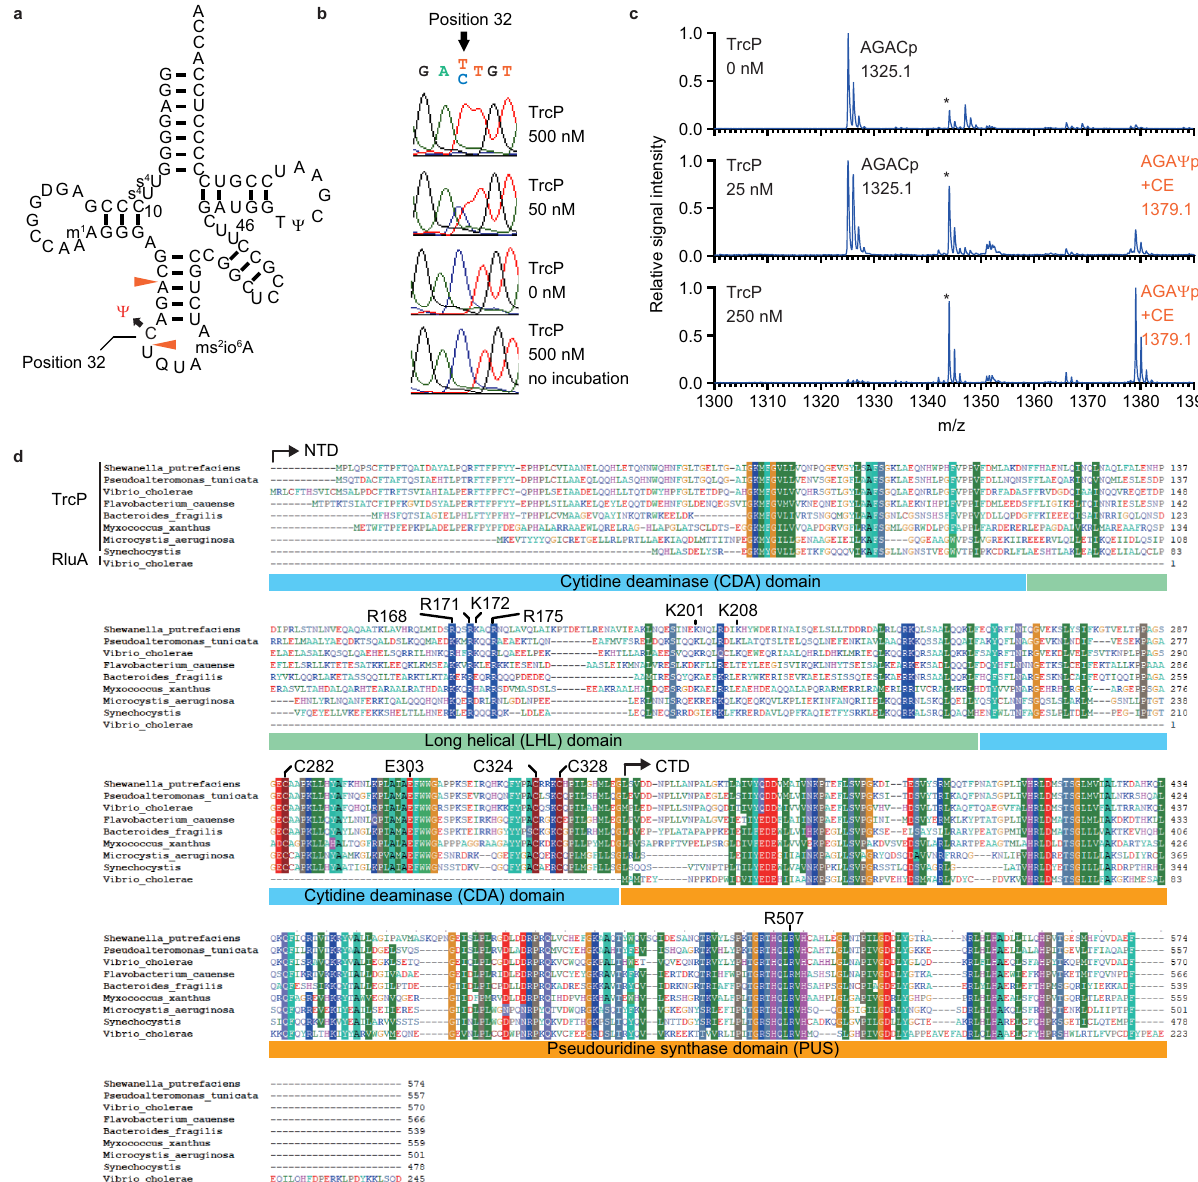
Fig. 1 | TrcP is suf fi cient to catalyze C-to- Ψ editing reaction. a Secondary structure of V. cholerae tRNA-Tyr. The C at position 32 is edited to Ψ . b Sanger sequencing of ampli fi ed cDNA derived from 250 nM tRNAs incubated with recombinant TrcP protein. TrcP concentrations are shown on the right. In the traces,redcorrespondstoT,andbluecorrespondstoC. c MALDI-TOFanalysisof an oligo-protected portion (positions 10 – 46) of tRNA-Tyr after incubation with recombinant TrcP protein. The tRNA fragment was treated with acrylonitrile to introduceacyanoethylgroup(53Da)onto Ψ .RNaseAdigestsofacyanoethylated RNA fragment were subjected to MS. The m/z values and assigned fragments are